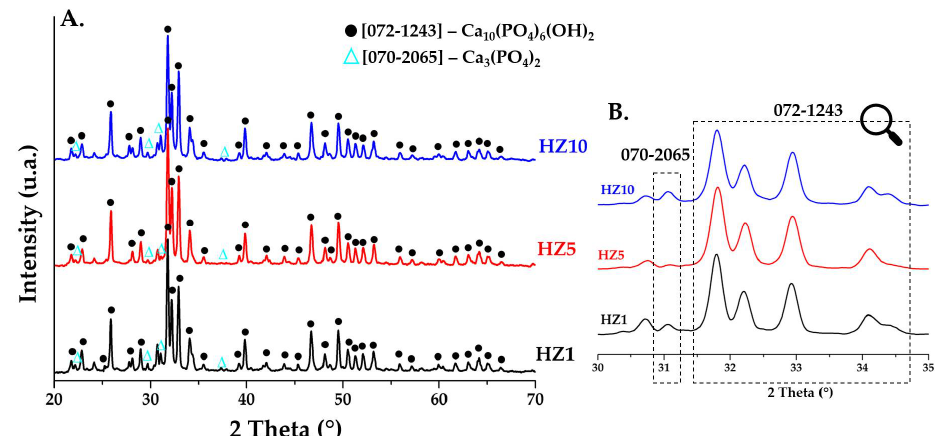
Figure 4. XRD patterns of ceramic powders obtained after calcination heat treatment at 900 °C for HZ1, HZ5, and HZ10 .